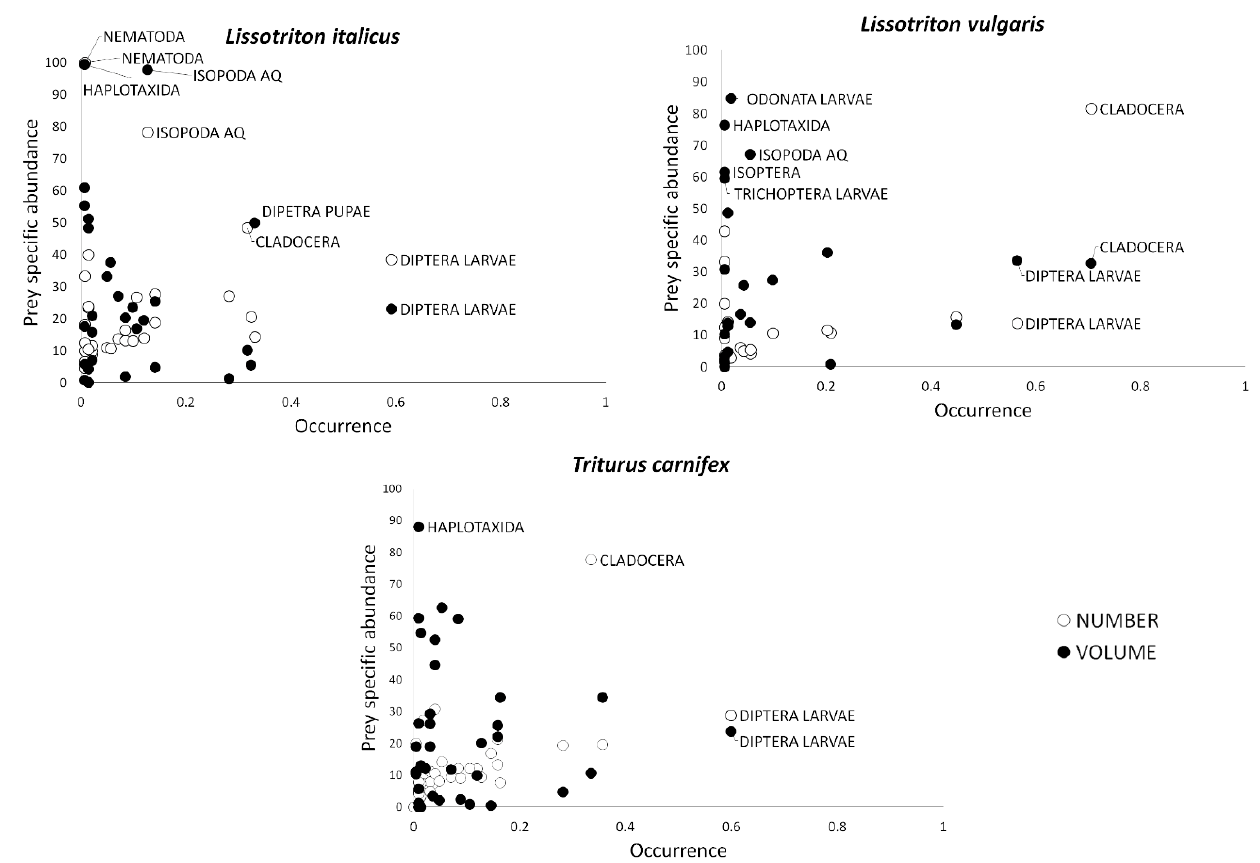
Figure 3. Costello-Amundsen graphical representation of Lissotriton italicus (LI), Lissotriton vulgaris (LV) and Triturus carnifex (TC) based on prey number (empty circles) and volume (black circles). Prey crucial for plot interpretation with dominant, frequent, or with high Pi values are labelled for clarity purposes. Table 3. Diet overlap values among Lissotriton italicus (LI), Lissotriton vulgaris (LV) and Triturus carnifex (TC) and between females and males within each species from all the study sites. Statistically significant values (i.e., those divergent from the null model) are reported in bold. Obs: observed value; exp: expected value generated by the null model; ns: non statistically significant values.